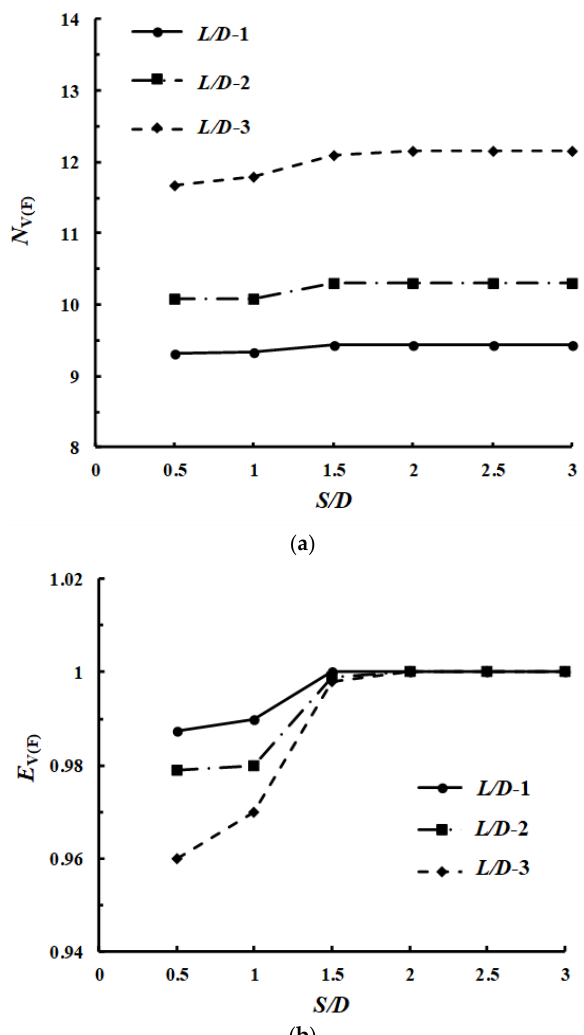
Figure 6. Vertical dimensionless load and group efficiency with L / D and S / D ratios: ( a ) vertical dimensionless load N V(F) ; ( b ) group efficiency E V(F) .